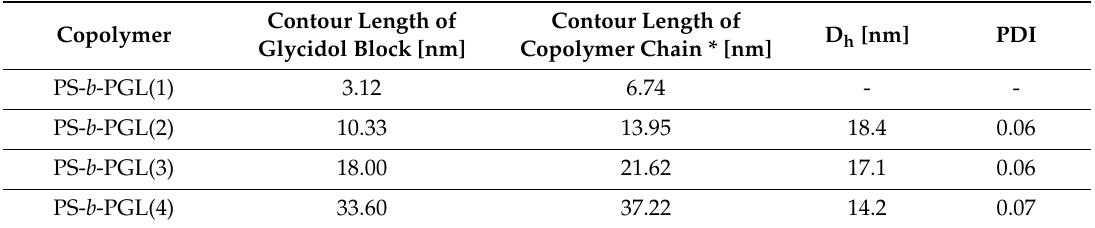
Table 2. Contour sizes of PS- b -PGL(X) copolymers and their PGL blocks and hydrodynamic diameters of copolymer micelles.